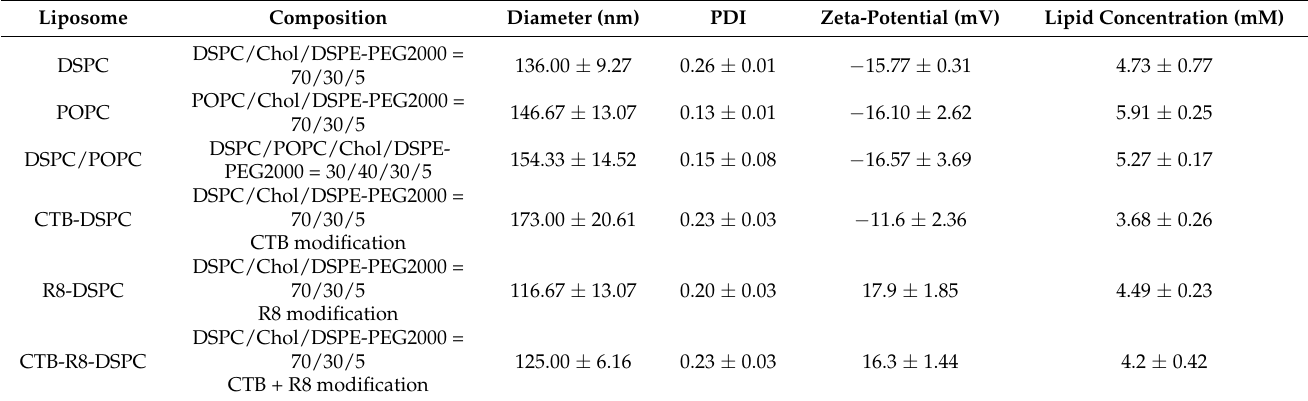
Table 1. The characteristics of